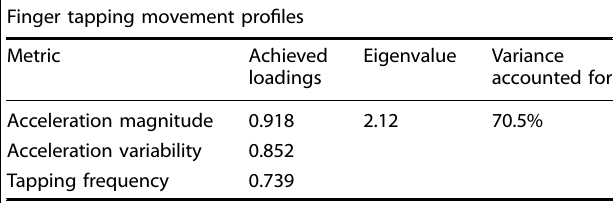
Table 2. Achieved loadings derived from